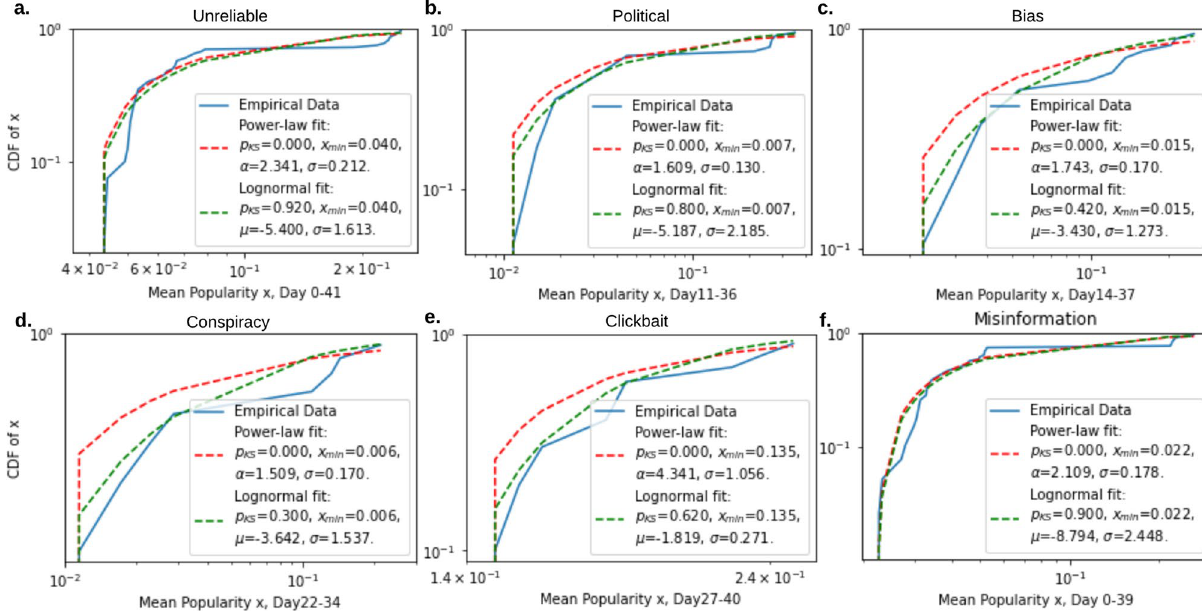
Figure 1. The fitted power-law model (red dash line) and log-normal model (green dash line) of the COVID-19 misinformation mean popularity. ( a–e ) Models fitted for different types of misinformation. ( f ) Models fitted for all COVID-19 misinformation. Log-normal is a plausible data-generating process of the misinformation mean popularity since the plausibility values p KS are greater than 0.1. Both goodness-of-fit test and likelihood ratio test indicate that compared to power-law, log-normal is more plausible. (Detailed hypothesis test procedure is stated in Methods section, “Power-law and log-normal analysis”.) The log-likelihood ratios ( R ’s) and significance values ( p ’s) between the two candidate distributions, log-normal and power-law, are (0.422, 0.429), (0.911, 0.289), (1.832, 0.245), (1.335, 0.352), (1.066, 0.369), (0.565, 0.203), for unreliable, political, bias, conspiracy, clickbait, and all types of misinformation,